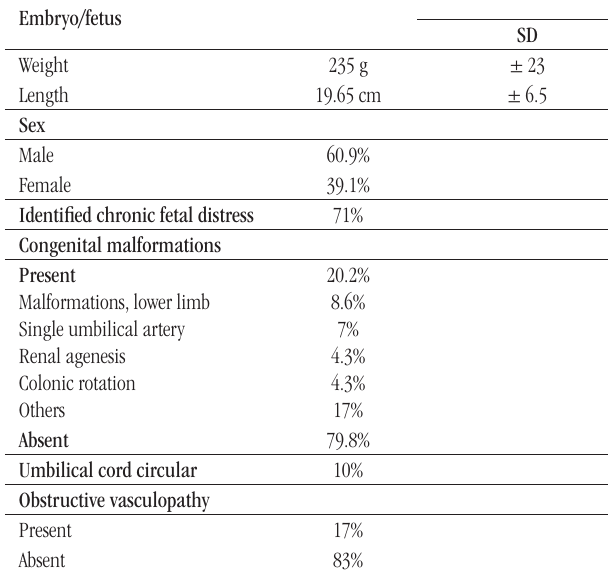
TABLE 2 – Description of the anatomopathological characteristics of embryos/fetuses